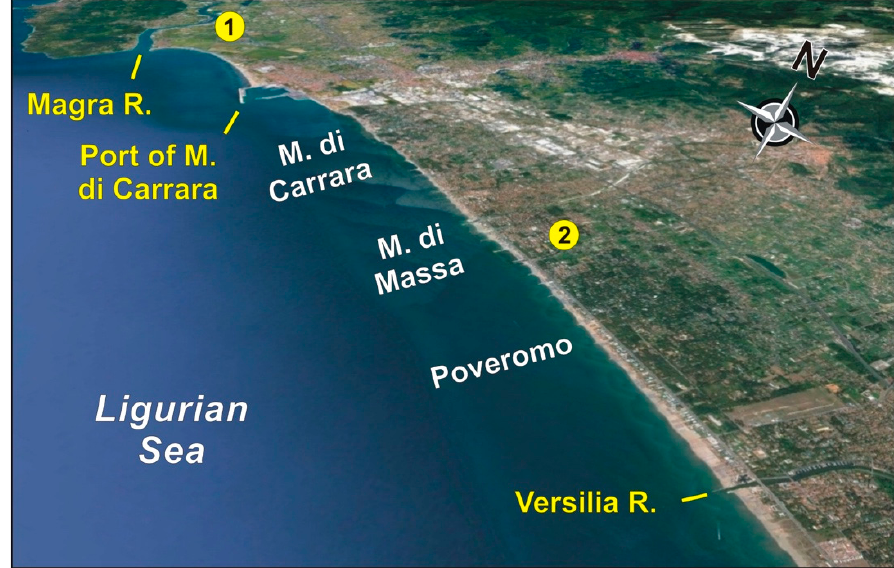
Figure 5. Aerial view (GoogleEarth database) of the northernmost sector of the study area (sub-cells 1 and 2), from the Versilia River mouth to the Magra River mouth. The image is tilted, so the scale is not uniform: as a reference, the distance between the Magra River mouth and the Versilia River mouth is about 14.5 km. Table 4. Volume of sediments redistributed as sediment transfer during the 1980–2020 timespan along the considered sector of coast, sorted by the nourishment area code. Refer to Table S2 for a detailed list of each transfer intervention.